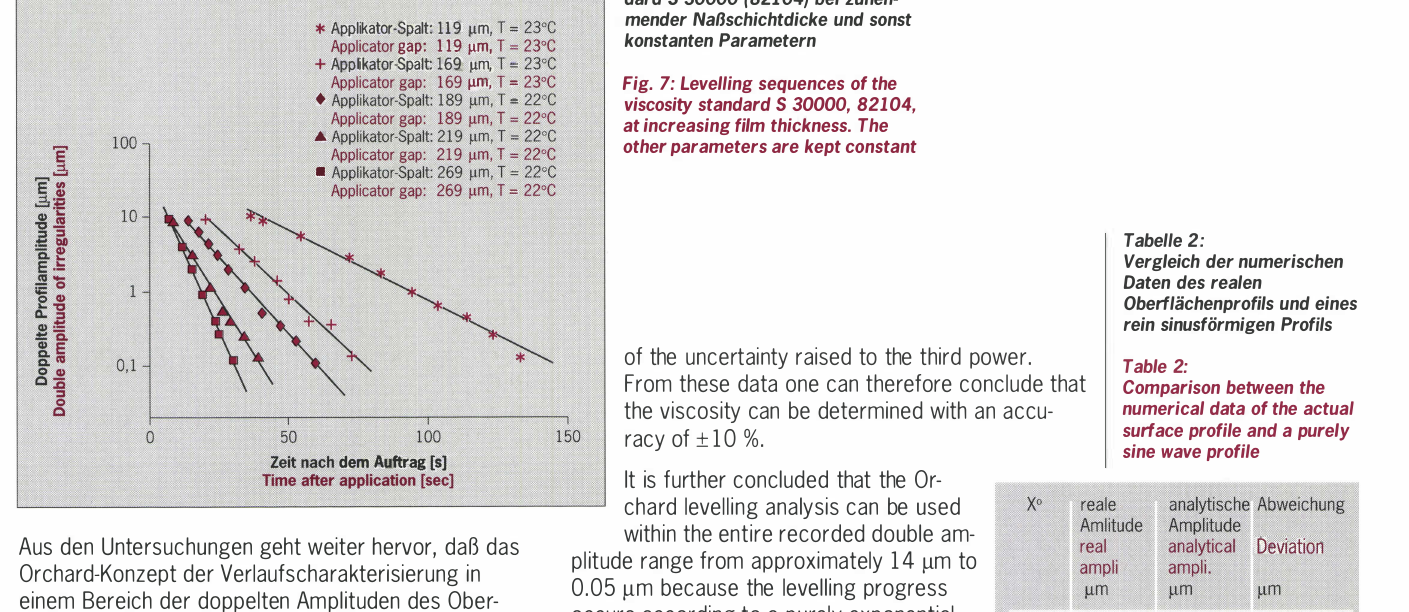
Abb. 7: Verlaufspriifserie mit Stan­ dardS 30000 (82104) bei zuneh­ mender NaBschichtdicke und sonst konstanten Parametern Fig. 7: Levelling sequences of the viscosity standardS 30000, 82104, at increasing film thickness. The other parameters are kept constant